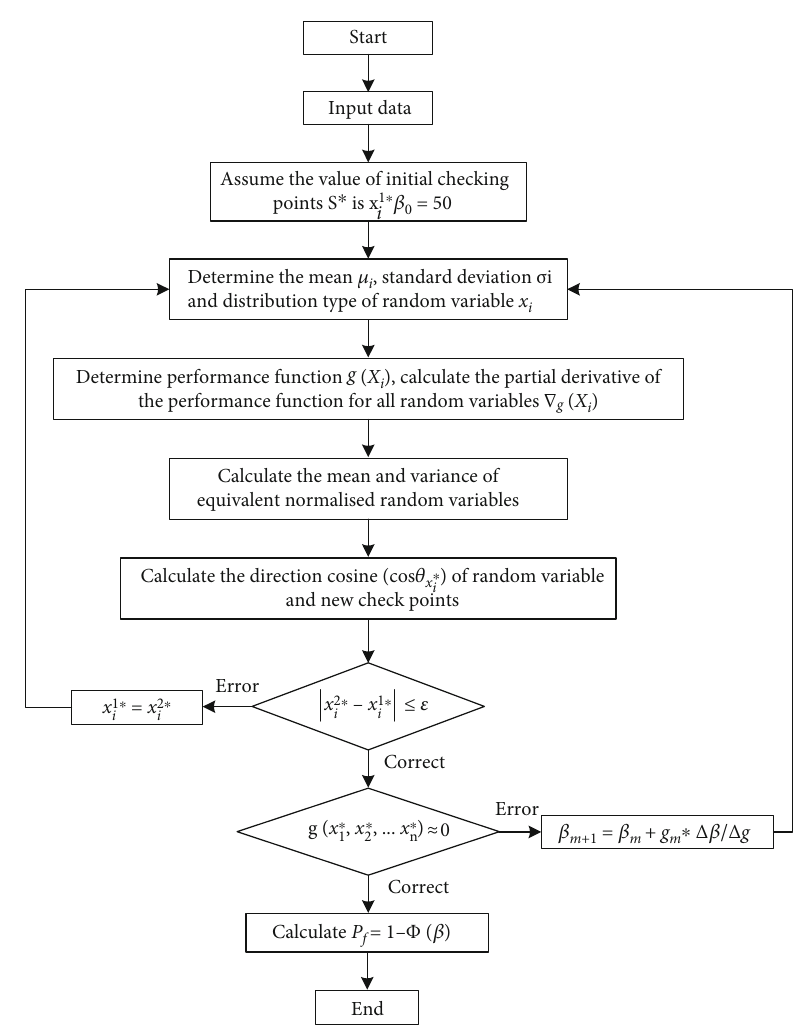
Figure 3: Flow chart of system failure Table 1: The main contents of the questionnaire for evaluating engineering geological practice route.